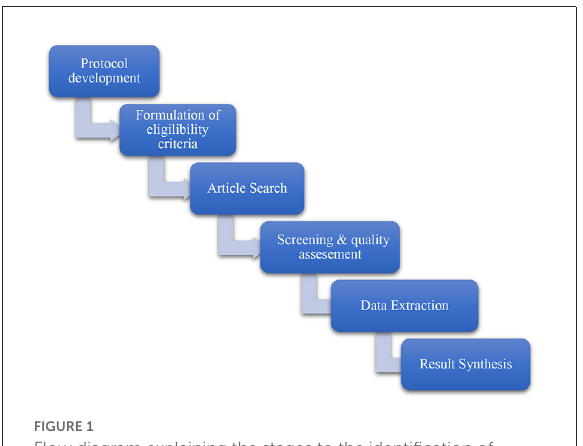
FIGURE1 Flow diagram explaining the stages to the identification of relevant